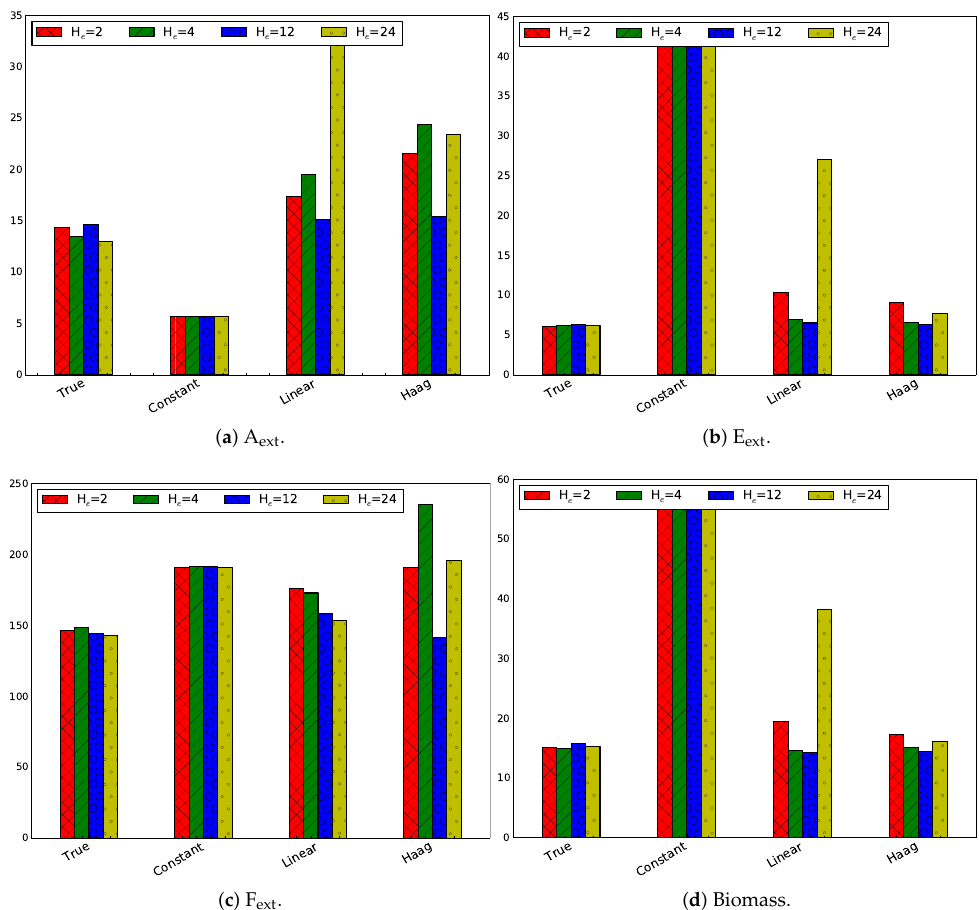
Figure 11. Absolute values of the absolute tracking error in case of H e = 4 h for the four states, i.e., the extracellular metabolite